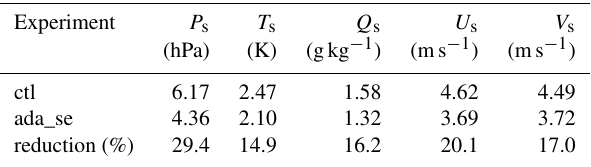
Table 3. Globally averaged RMSEs of surface pressure P s , surface temperature T s , surface specific humidity Q s , surface zonal wind U s , and surface meridional wind V s from ctl and ada_se. The RM- SEs are calculated with the data of the first month